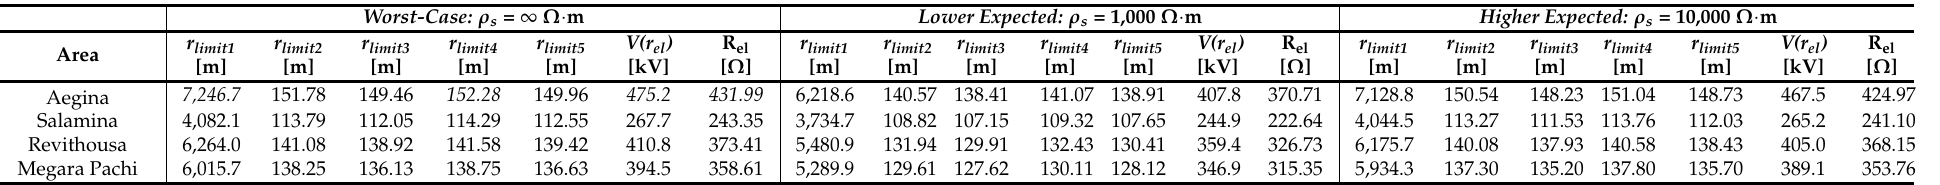
Table 2. Minimum values of distances for absolute potential in relation to remote earth, for potential gradient/electric field strength in steady and transient state, absolute potential at electrode surface and equivalent electrode resistance in the area of Stachtoroi (Attica) in relation to neighboring coasts based on method “A” according to Equations (8) and (9), (74), (76) and (77).